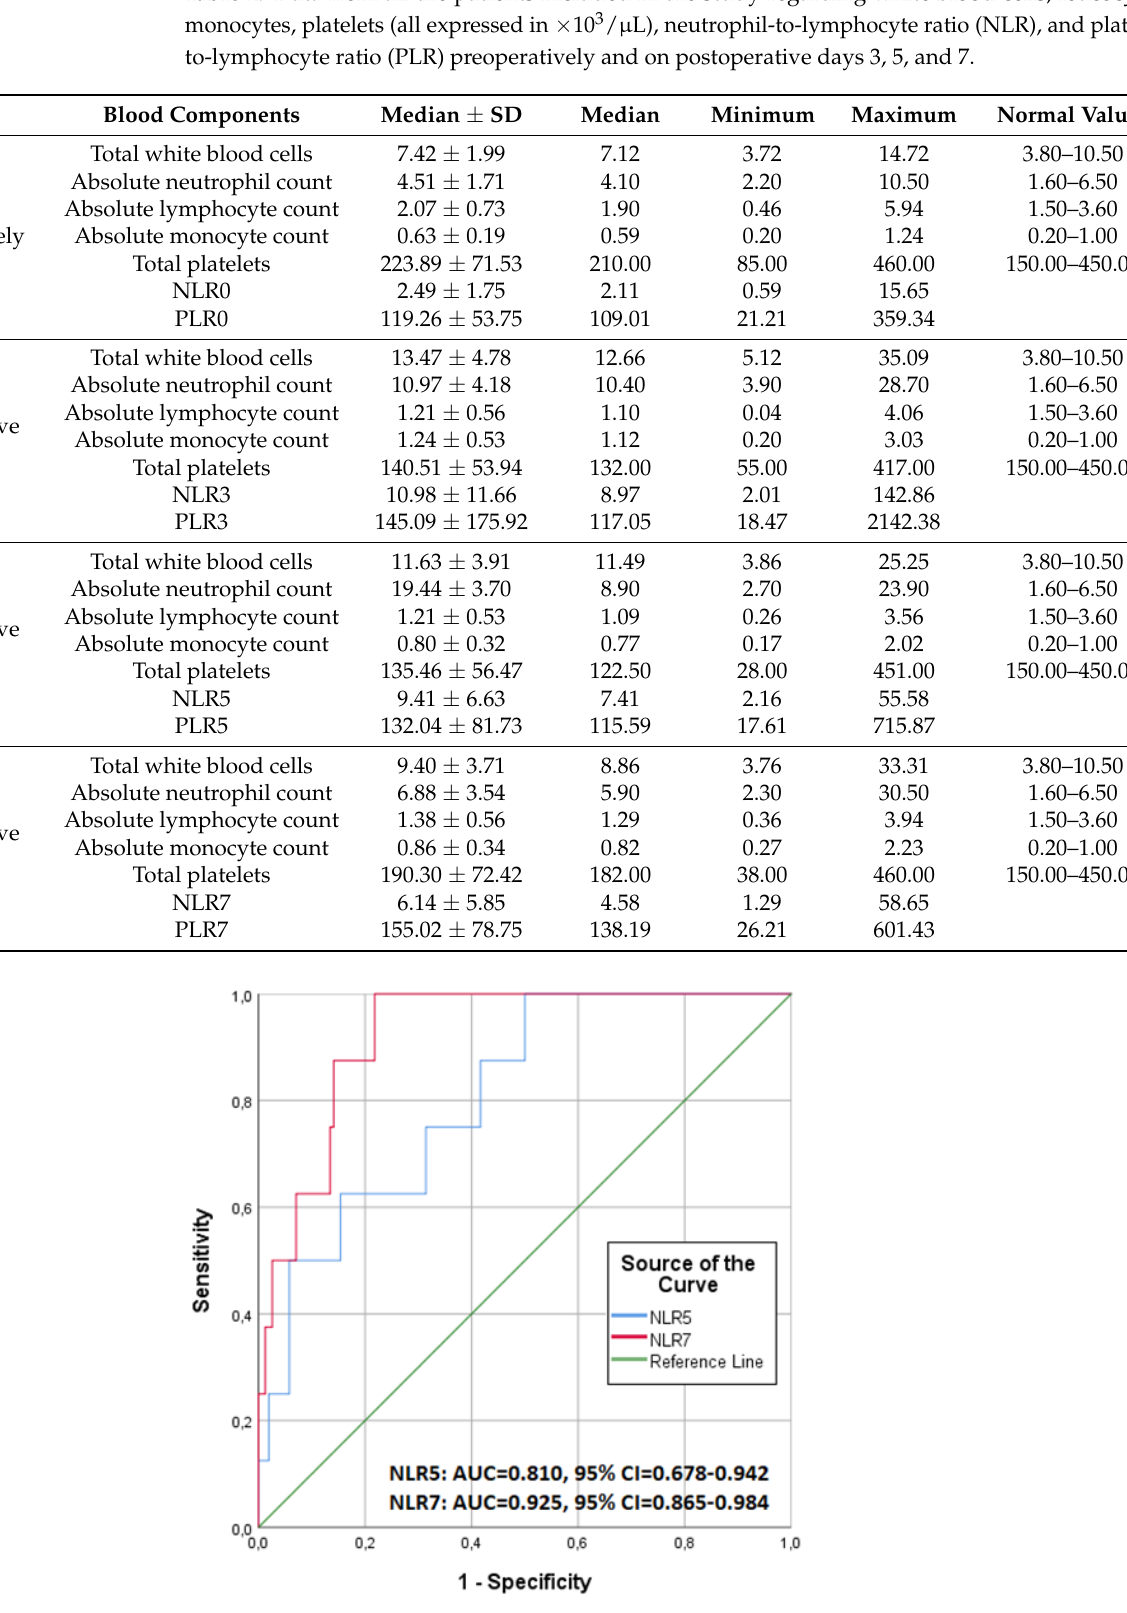
Figure 2. Receiver operating characteristic (ROC) curves for predicting 90-day mortality for neutrophil-to-lymphocyte ratio (NLR) calculated on the 5th (NLR5) and the 7th (NLR7) postoperative day. 161 When patients were divided according to the optimal cut-off point of 6.60 for NLR7, 162 the mortality was found to be 20.00% (11 out of 55 patients) in patients with an NLR7 163 value > 6.60, which was significantly higher compared to the survival of the rest of the 164 patients (0%, p < 0.001) and that the whole sample overall (20.00% vs. 6.15%, p = 0.002) as 165 well. Similarly, after patients had been divided according to the optimal cut-off point of 166 7.10 for NLR5, the mortality was 10.52% (10 out of 95 patients) in patients with an NLR5 167 value >7.10, which was also significantly higher compared to the mortality of the patients 168 wi th NLR5 value ≤ 7.10 (1.19%, p = 0.011), but not compared to the overall survival of the 169 sample (10.52% vs. 6.15%, p = 0.194).